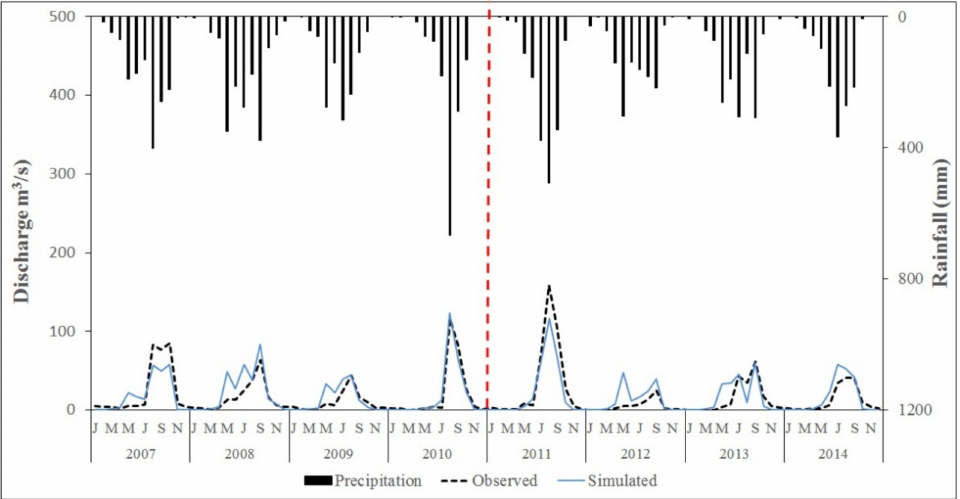
Figure 3. Hydrograph obtained during calibration (2007 to 2010) and validation (2011 to 2014) at kh.92